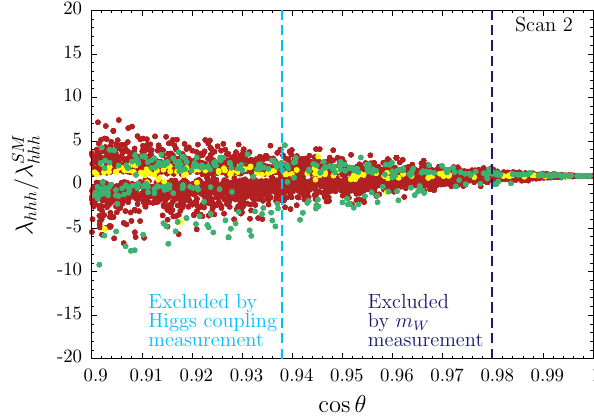
ble/metastable/stable configurations. The dashed vertical lines indicate the bounds on cos θ from the respective experimental measurements. Right: Same as in left panel, but for scan 2 (weakly coupled